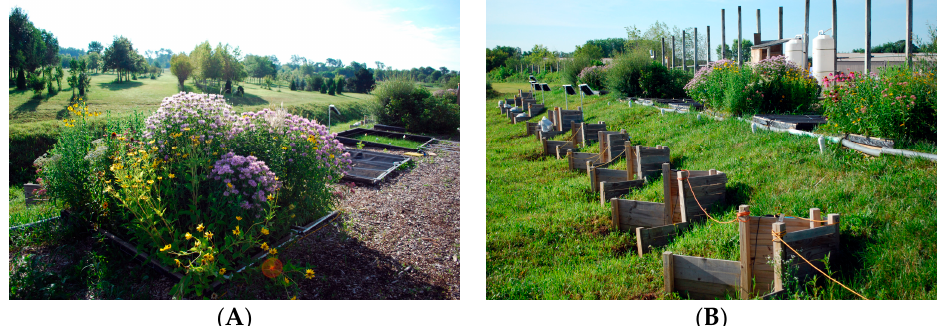
Figure 2. Twelve closed-hydrology mesocosms were established along a berm to monitor drainage responses to inputs of stormwater. Four vegetative treatments were used: turfgrass, prairie plants, shrubs, and controls lacking vegetation ( A ). Each mesocosm drained freely to a flow monitoring station located behind a wooden retaining wall ( B ).